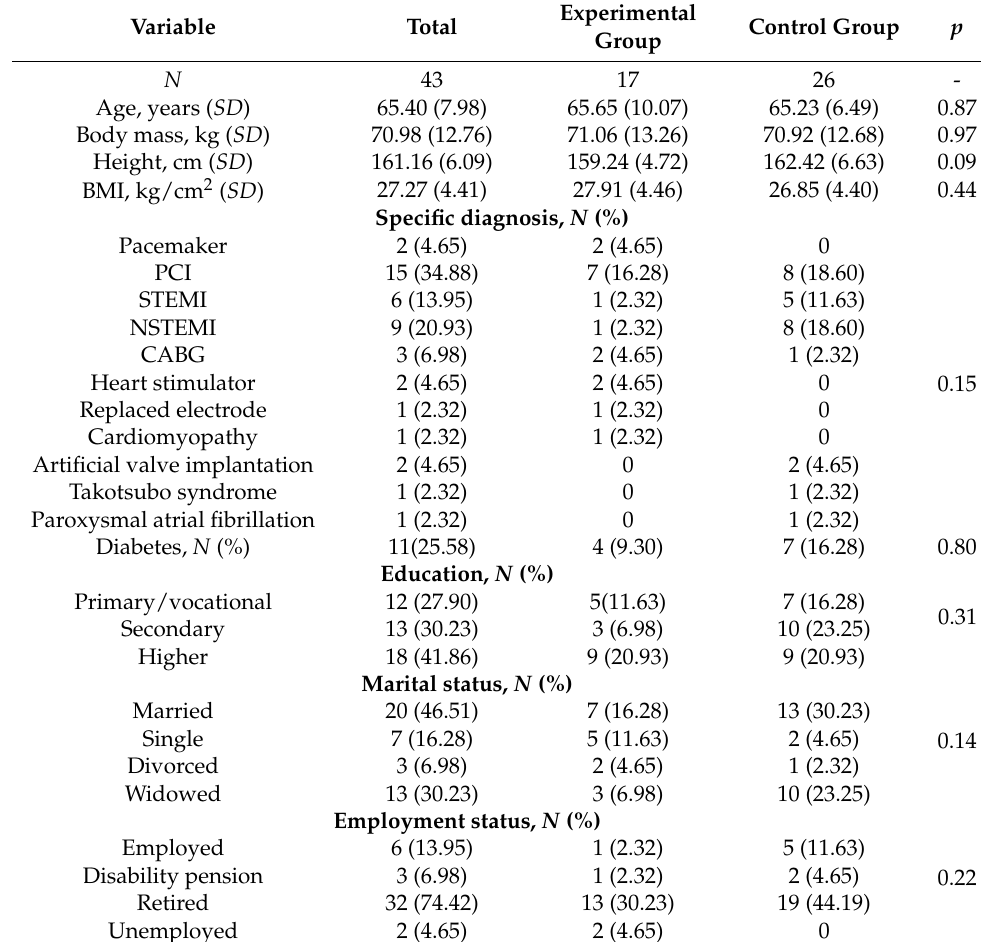
Table 1. Participant baseline